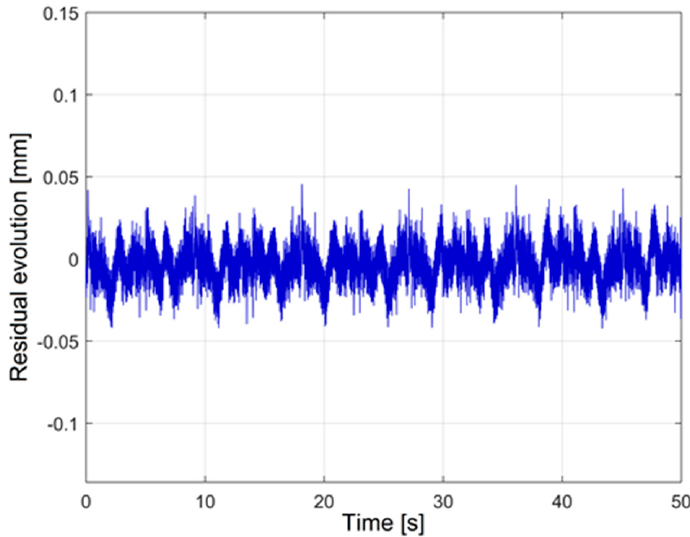
Figure 6. The evolution of residual x r from the harmonic fitting model for x -motion. The evolution of residuals from Figures 6 and 7 indicates that the negative effect on P&A of x -motion errors is smaller than of y -motion